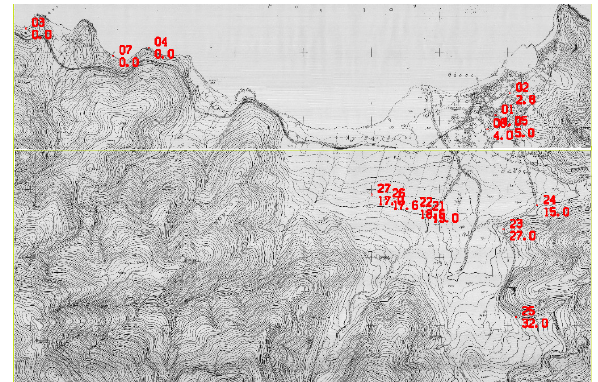
Figure 6. Distribution of the GCPs on the maps in Thassos.